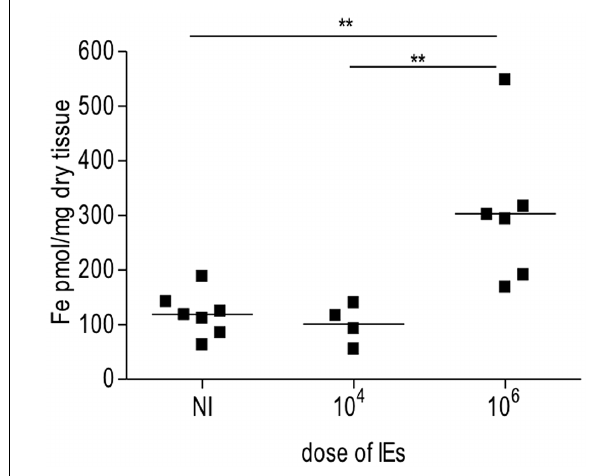
FIGURE 3 | Iron accumulation in placenta is dependent on dose of infection. Pregnant mice were infected with either 10 4 or 10 6 Plasmodium berghei -infected erythrocytes (IEs). Placentas from Plasmodium -infected pregnant mice were collected at G19/20 and processed for iron measurements as previously described (Gozzelino etal., 2012). Briefly placentas were dehydrated overnight, dissolved in 3 M HCl/trichloroacetic acid (TCA) 10% for 24 h. Labile iron was detected by colorimetric reagent (bathophenanthroline-disulfonic acid; BPTS) and absorbance was measured by spectrophotometer (SmartSpec 3000, Bio-Rad); ** p < 0.01. Table 2 | Iron accumulation in placentas from dead fetuses according to IE dose. Iron